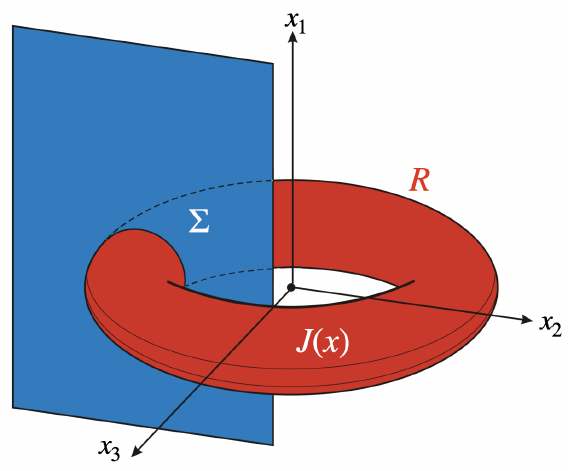
Figure 3 . Example of the integration surface Σ . Here we use coordinates ( x 1 , x 2 , x 3 ) with the surface Σ being orthogonal to x 3